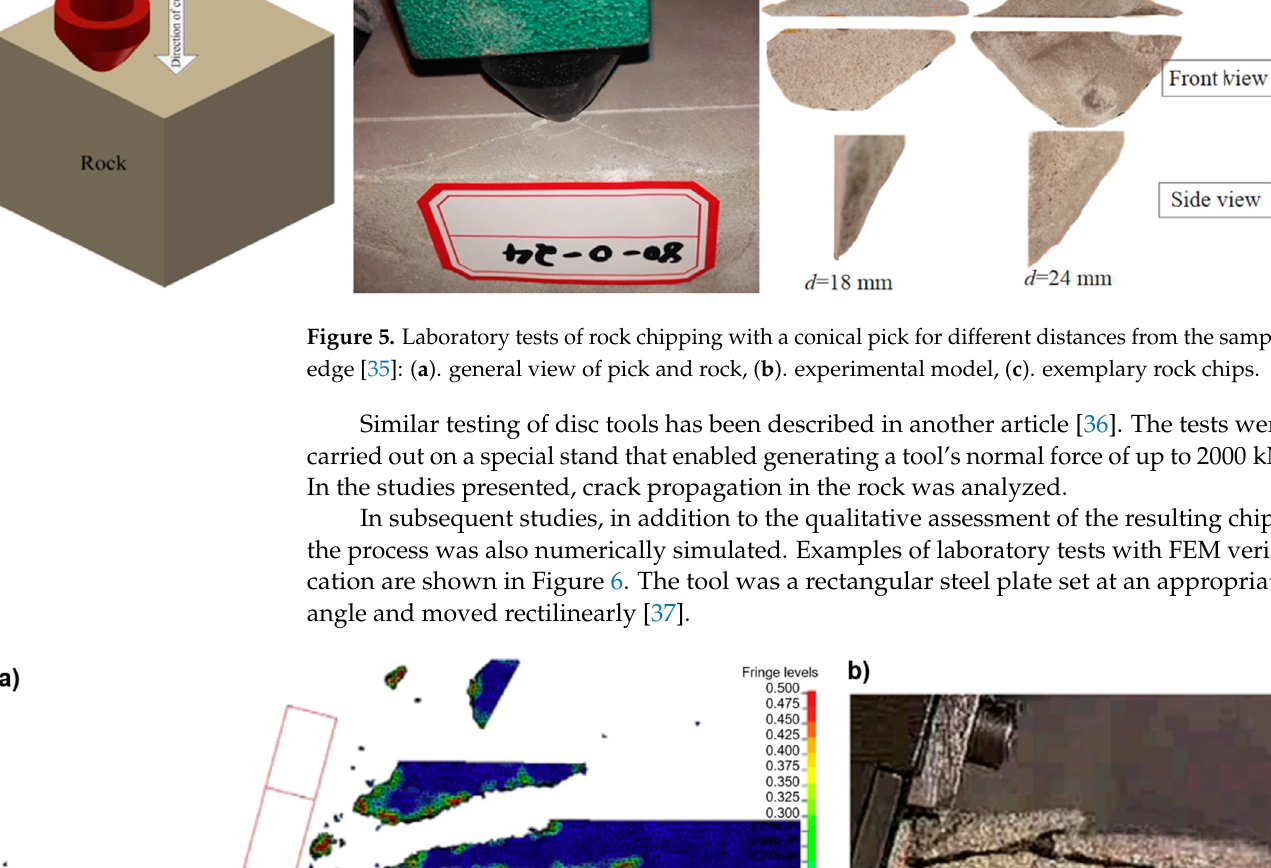
Figure 5. Laboratory tests of rock chipping with a conical pick for different distances from the sam- ple edge [35]: ( a ). general view of pick and rock, ( b ). experimental model, ( c ). exemplary rock chips.